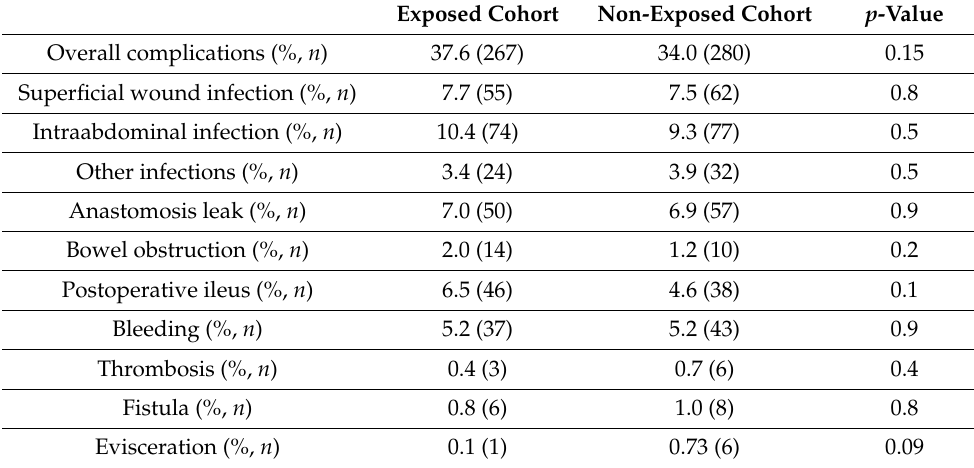
Table 2. Effect of biological treatment on the incidence of postoperative complications calculated by Chi-square